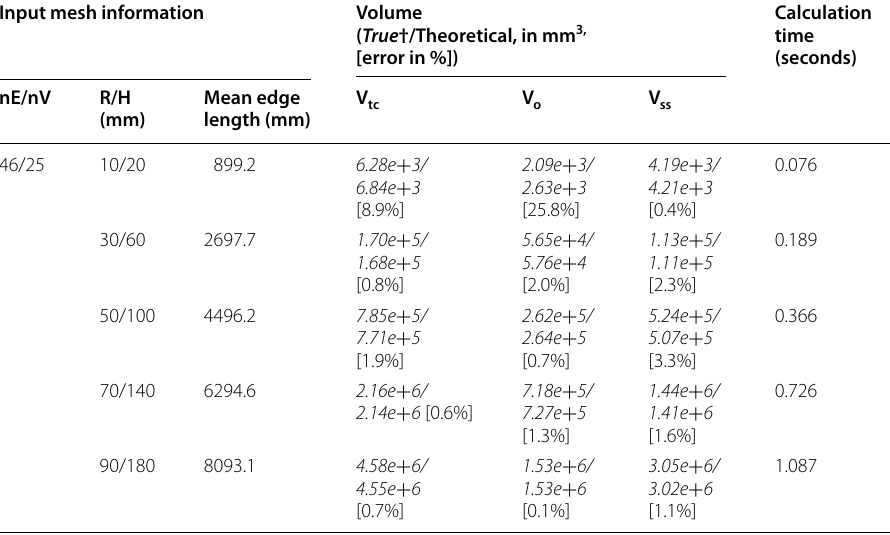
Table 4 Volume error estimation for “Inverted